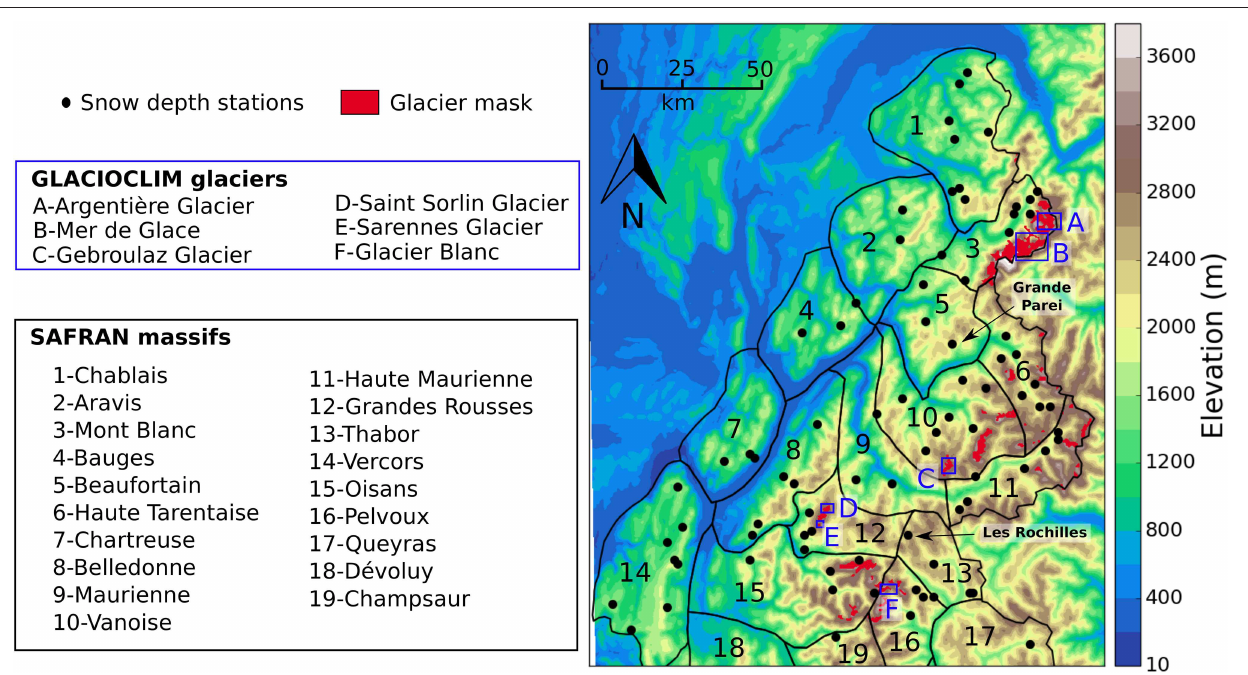
FIGURE 1 | Map of the simulation domain showing the topography at 500-m grid spacing. Black dots show the location of stations measuring snow depth (87 in total). The glacier mask (see text for more details) appears in red (only available in France) and glaciers monitored by the GLACIOCLIM observatory (blue boxes) are listed. Contours (black lines) and names of the SAFRAN massifs are also given on the map.